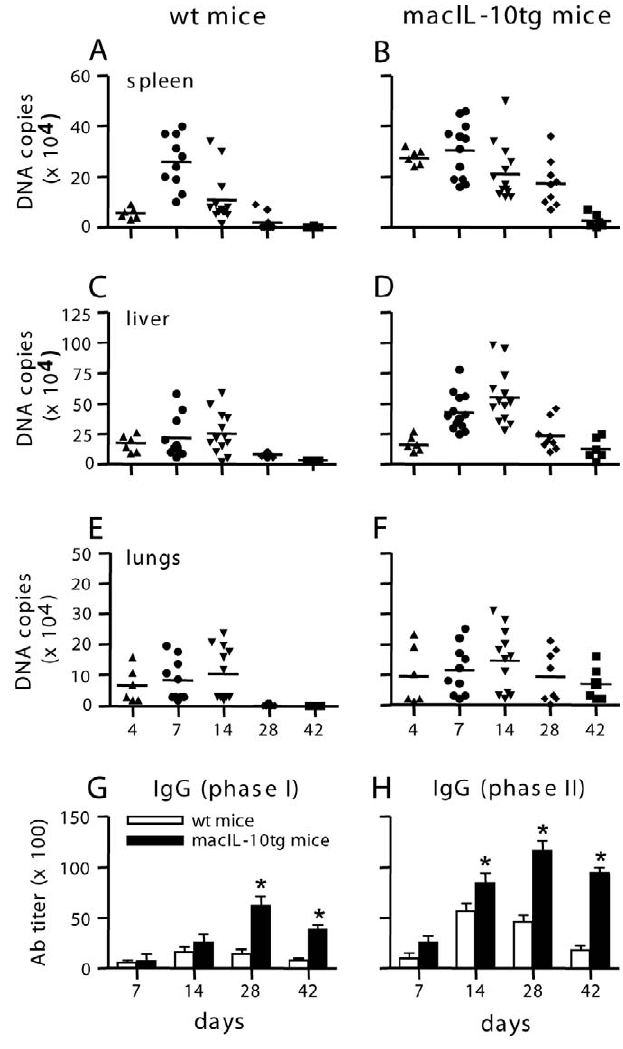
Figure 1. C. burnetii Infection in WT and macIL-10tg Mice (A–F) Tissue bacterial burden was measured by qPCR. The results are expressed as the number of C. burnetii DNA copies for each infected mouse. Bars represent the median of values for each time point. (G–H) The titer of specific Abs directed against C. burnetii in phase I and phase II was assessed by immunofluorescence using inactivated C. burnetii . The results are expressed as mean 6 SD of at least five mice/ time point. * p , 0.05.